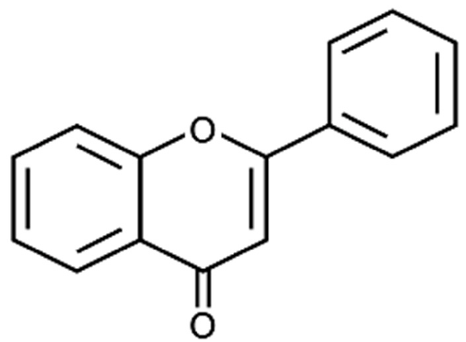
Figure 2. Chemical structure of flavonoids. Adapted from Nabavi et al. [21].